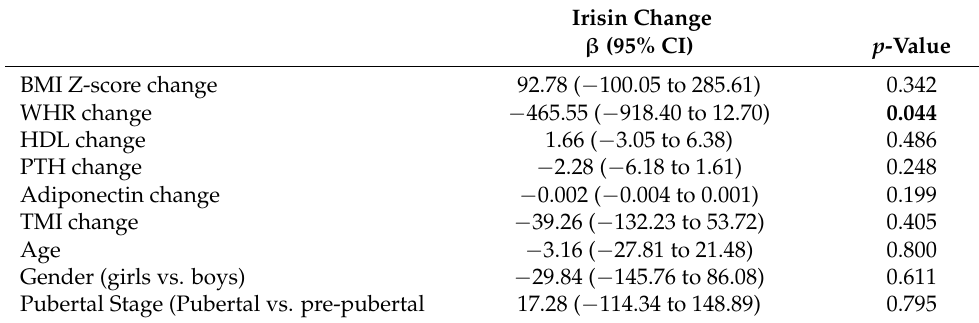
Table 5. β regression coefficients for the Irisin